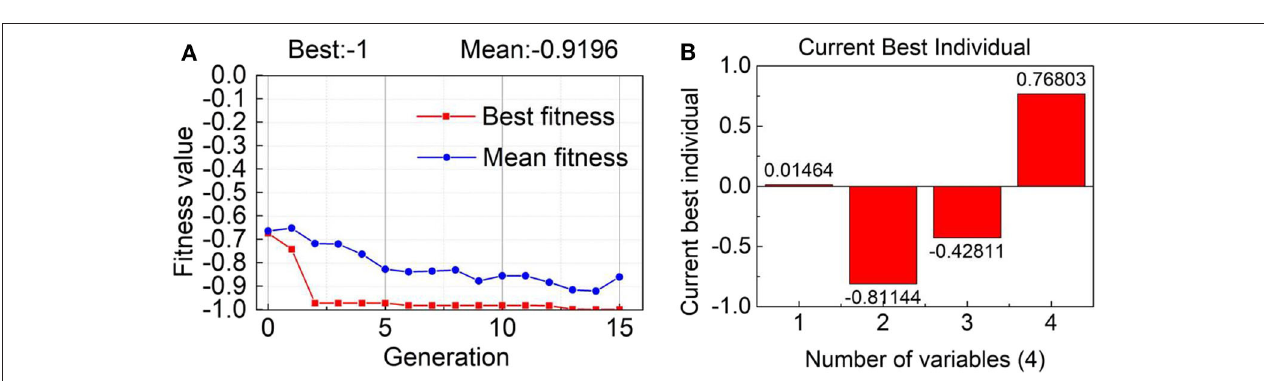
FIGURE 4 | GA optimization. (A) The process of GA optimization and (B) the current best